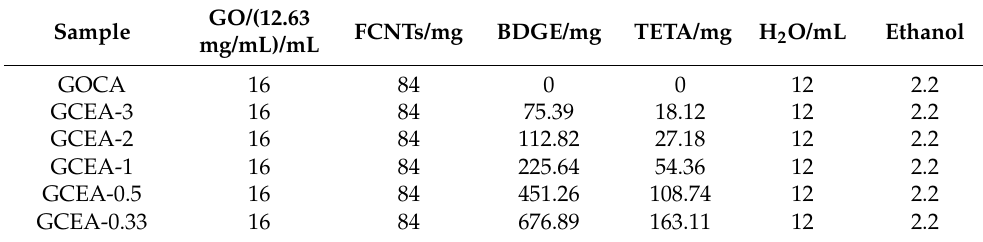
(c,d) of GCEAs; Figure S2: Compressive stress-strain cyclic curves of (a) GCEA-0.33, (b) GCEA- 3. Figure S3: compressive stress-strain cyclic curves of GCEA-0.5, GCEA-1 at strain of 40% for 7 cycles. Figure S4: Frequency dependence of (a) ε (cid:48) , (b) ε (cid:48)(cid:48) , (c) tan δε for the samples of GCEA-1, GCEA-0.5; Figure S5: (a,b) reflection loss plots of GCEA-0.5, GCEA-1, Figure S6: ε (cid:48) − ε (cid:48)(cid:48) plot of GO (a), FCNTs (b), GOCA (c), GCEA-2 (d), GCEA-1 (e), GCEA-0.5 (f). References [46,47] are cited in the supplementary